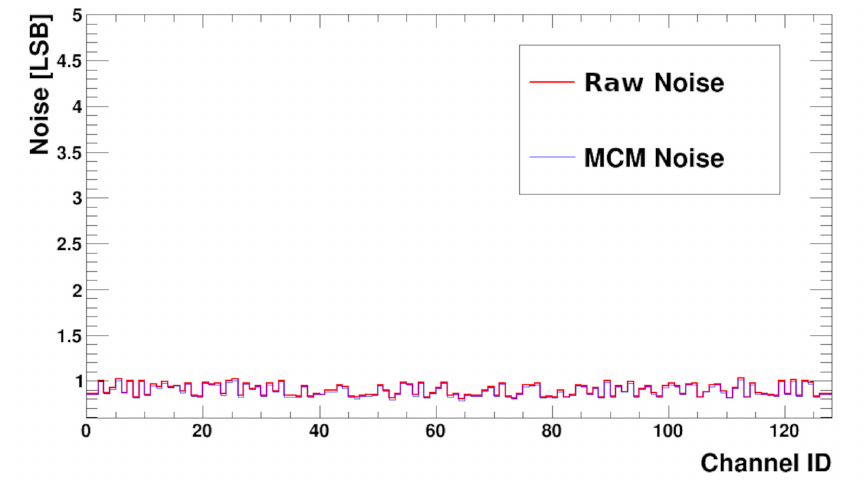
Figure 17. Baseline noise RMS versus channel number shown without and with MCM correction with a biased UT sensor